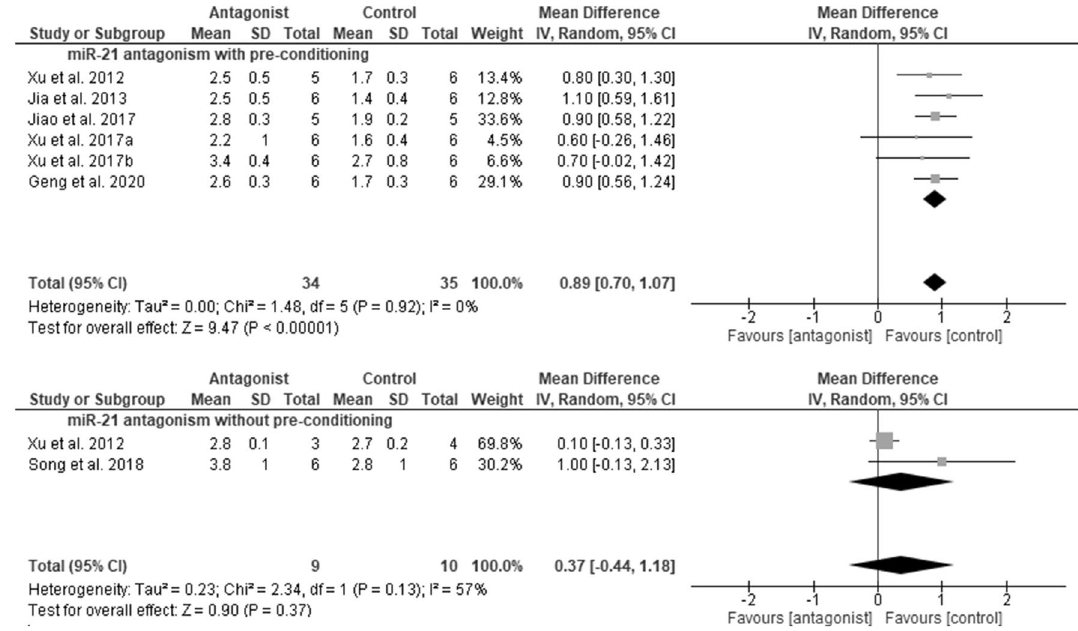
Figure 5. Meta-analyses of miRNA-21 antagonism on injury scores in AKI models (in the presence or absence of pre-conditioning). SD, standard deviation; CI, confidence